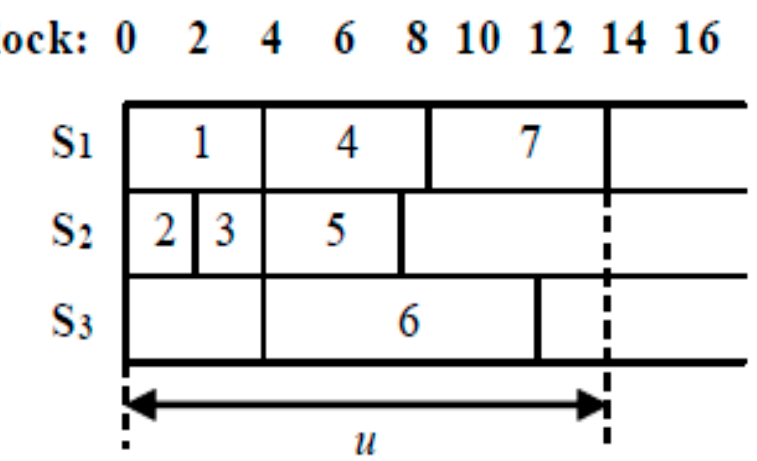
Figure 6. Plan for implementation of the processes from Figure 3d in a system with three proces-